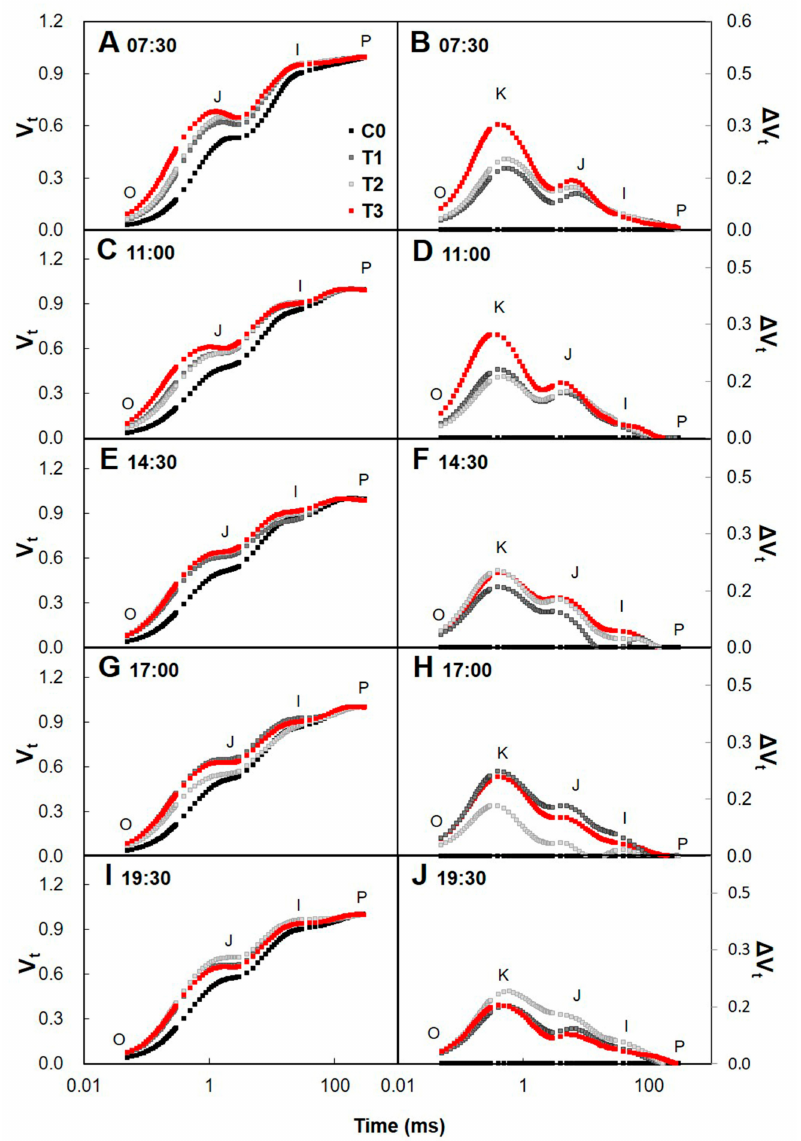
Figure 2. Comparison of Chlorophyll a fluorescence (OJIP) transients of control (C0, natural day/night cycle) and the day/night with artificial lighting cycle (T1, T2, and T3) after two years of artificial night lighting treatment. OJIP transients were induced by a 1 s light pulse of 3500 µ mol · m − 2 · s − 1 . ( A , C , E , G , I ) Represent relative fluorescence kinetics (V t ) and ( B , D , F , H , J ) represent ∆ V t (different kinetics of OJIP transients) among treatments at 07:30, 11:00, 14:30, 17:00 and 19:30, respectively. V t at time t derived from the mean OJIP transients between F O and Fm, was defined as: V t = (F t − F O )/(F M − F O ). ∆ V t refer to differences of the V t of all